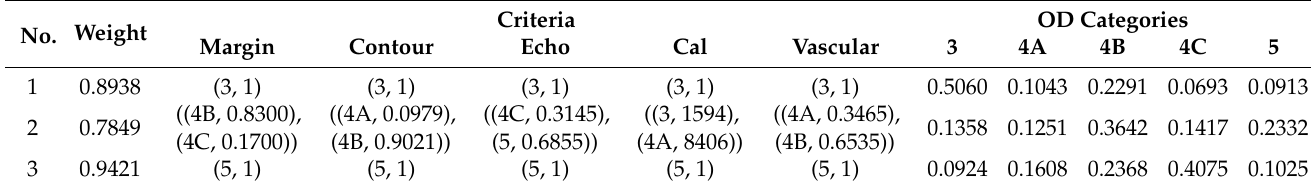
Table 5. BRB of Doctor No. 3 under the deletion assumption.